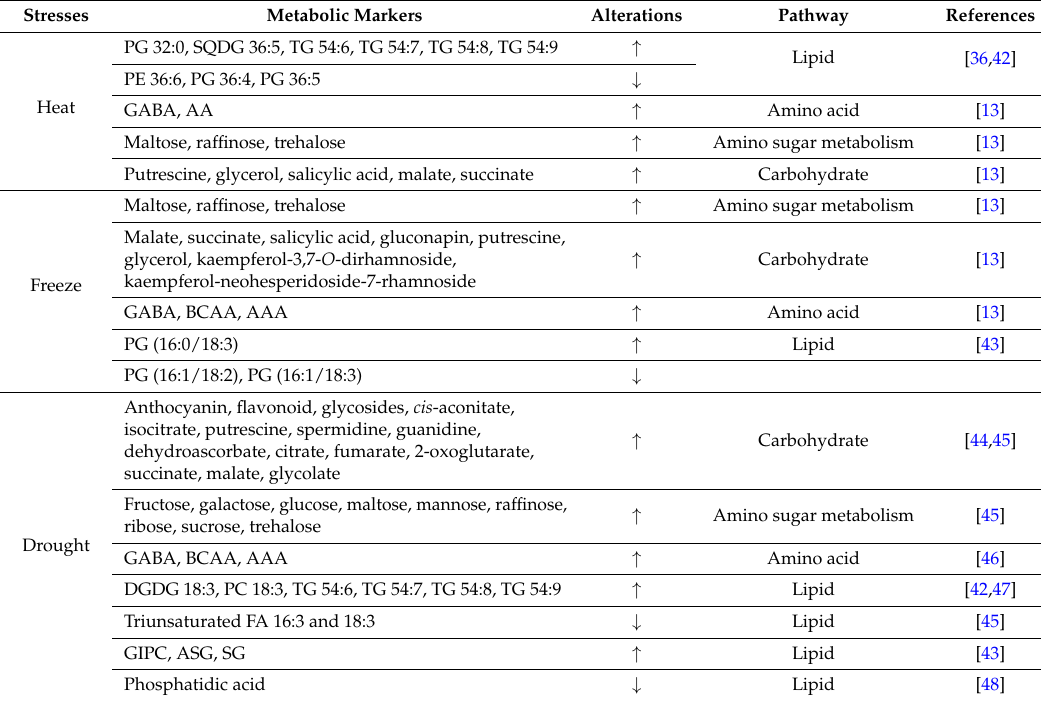
Table 2. Metabolomic profiling of the physiological responses to heat, freezing, drought, and salt stresses in Arabidopsis